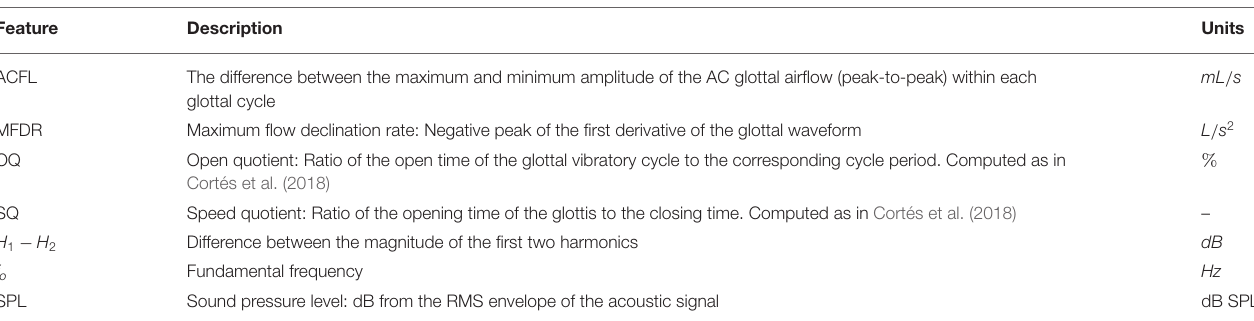
TABLE 1 | Description of aerodynamic features extracted from the glottal airflow signal and acoustic sound pressure level extracted from the microphone or accelerometer signal. Feature Description Units